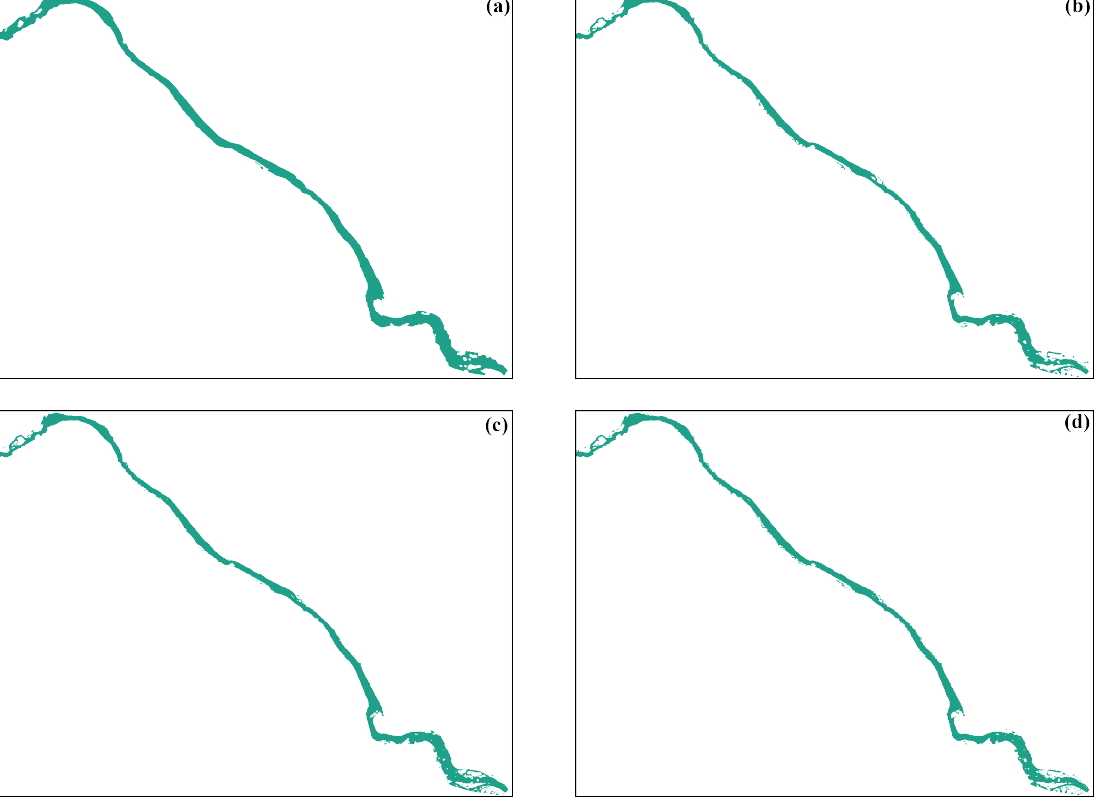
Figure 5. The 400-DPI image files generated for A wetted calculation in the mesh study. The black borders correspond to A total . ( a ) Coarse mesh. ( b ) Less-fine mesh. ( c ) Finer mesh. ( d ) Finest